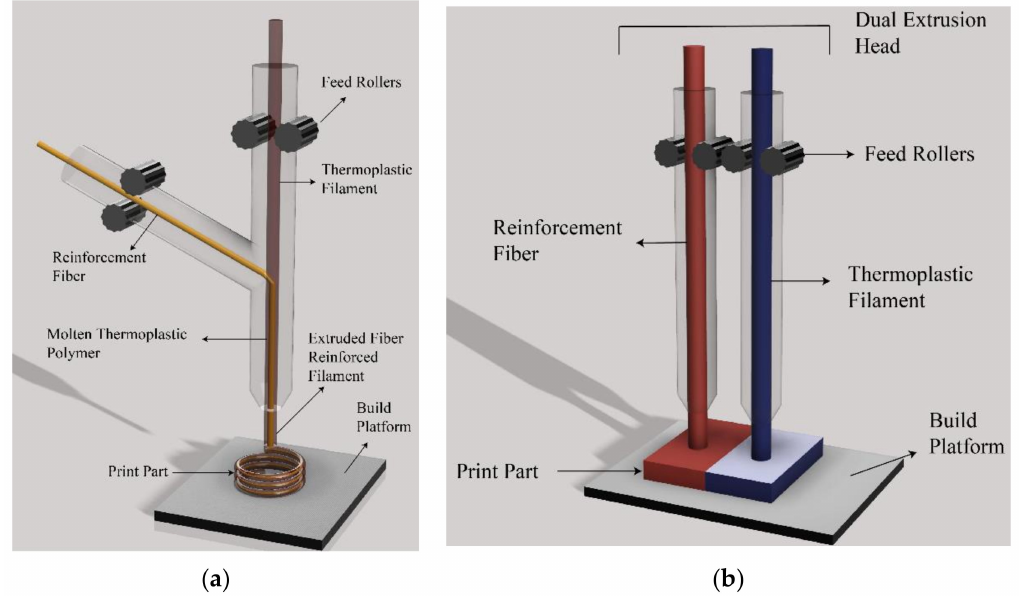
Figure 5. ( a ) Co- and ( b ) dual-extrusion 3D printing of PLA with continuous fibers (adapted from Reference [8], copyright 2020, MDPI